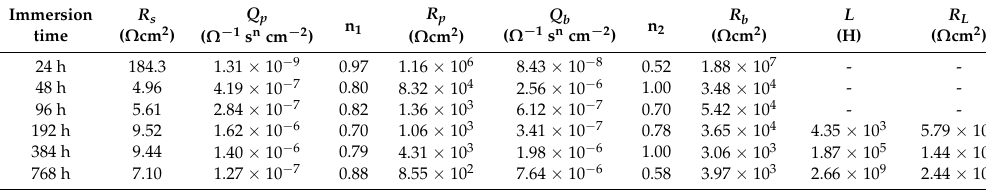
Table 4. Equivalent circuit data of coatings immersed in 3.5 wt % NaCl solution.